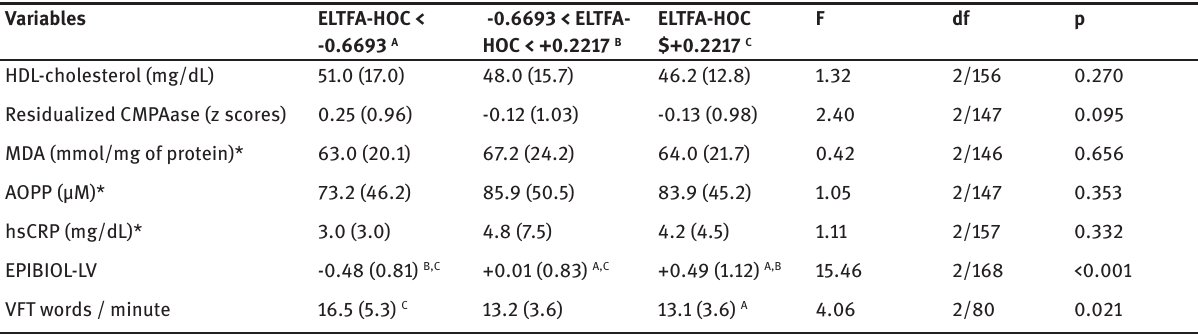
Table 3: Biomarker data and verbal fluency test (VFT) results in subjects divided into high, medium and low values of an early life trauma (ELT) latent vector